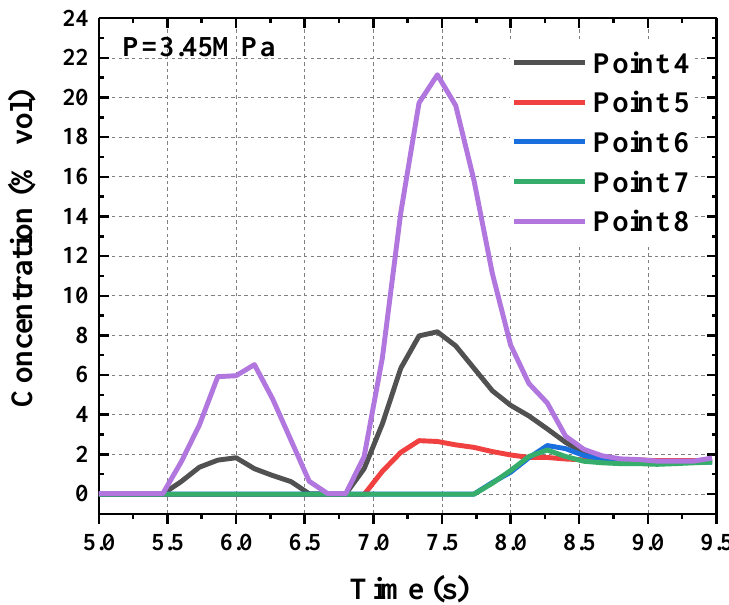
Figure 13. Concentration as a function of time at points 4, 5, 6, 7, and 8 in Section II in the case of 3.45 MPa.